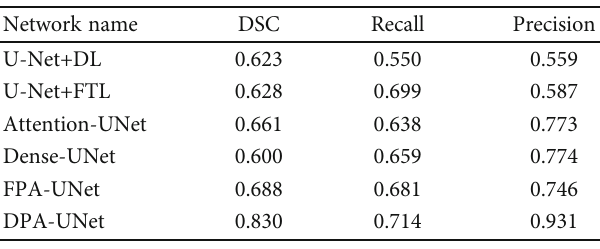
Figure 2: Network training error rate. Table 2: U-Net and its improved network evaluation index comparison table.